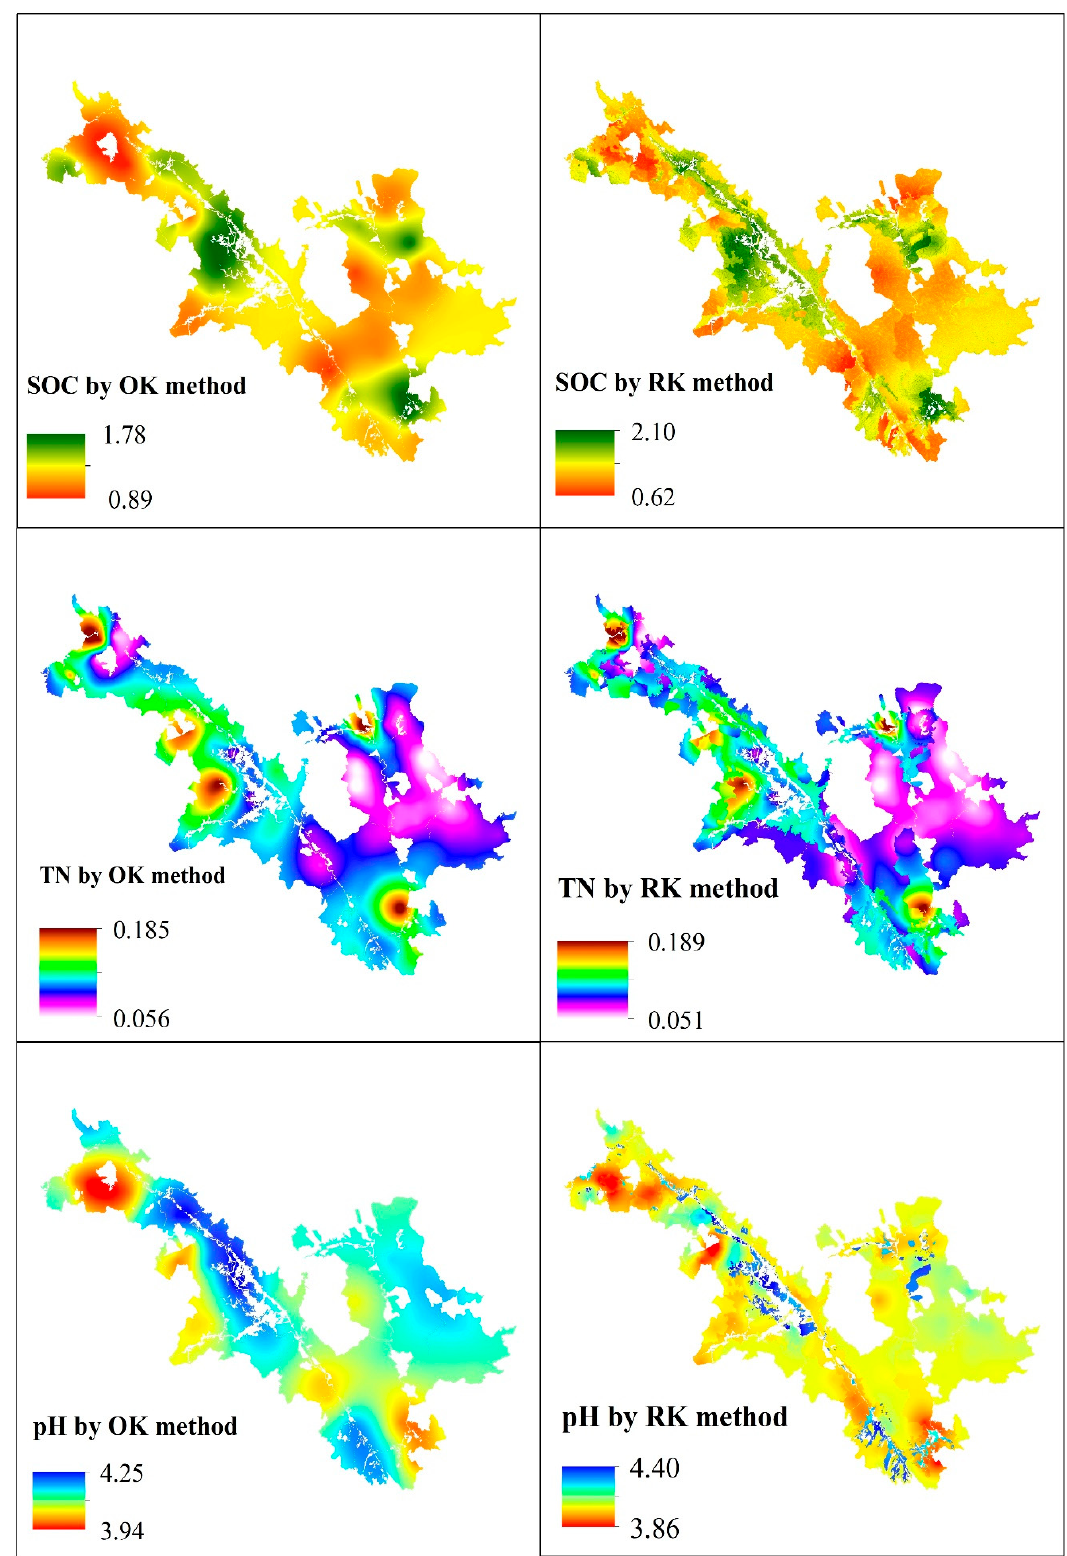
Figure 5. Maps of SOC, TN, pH by OK method ( left ) and by RK method ( right ).